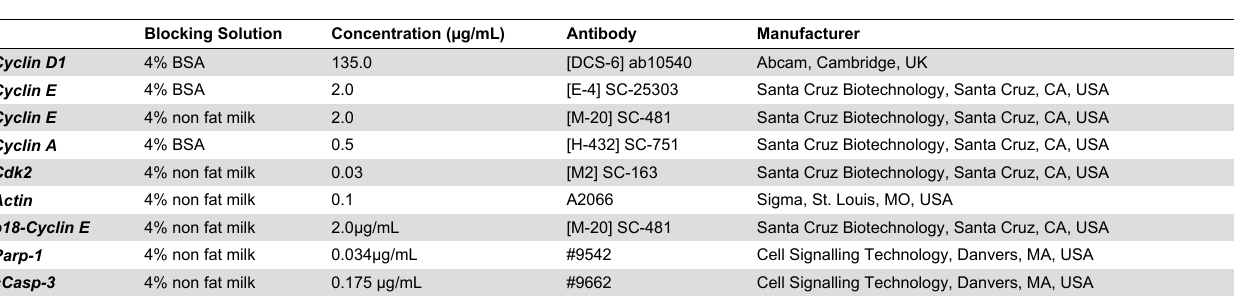
Table 2. Antibodies used for Western